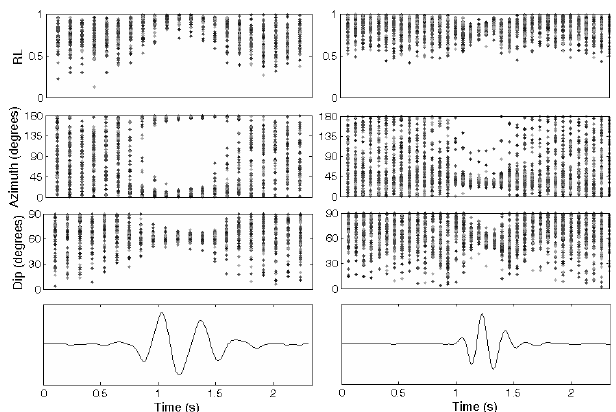
Fig. 6. Typical shape of “events” of the sub-classes a (top), b (mid- dle) and c (bottom) detected in the series